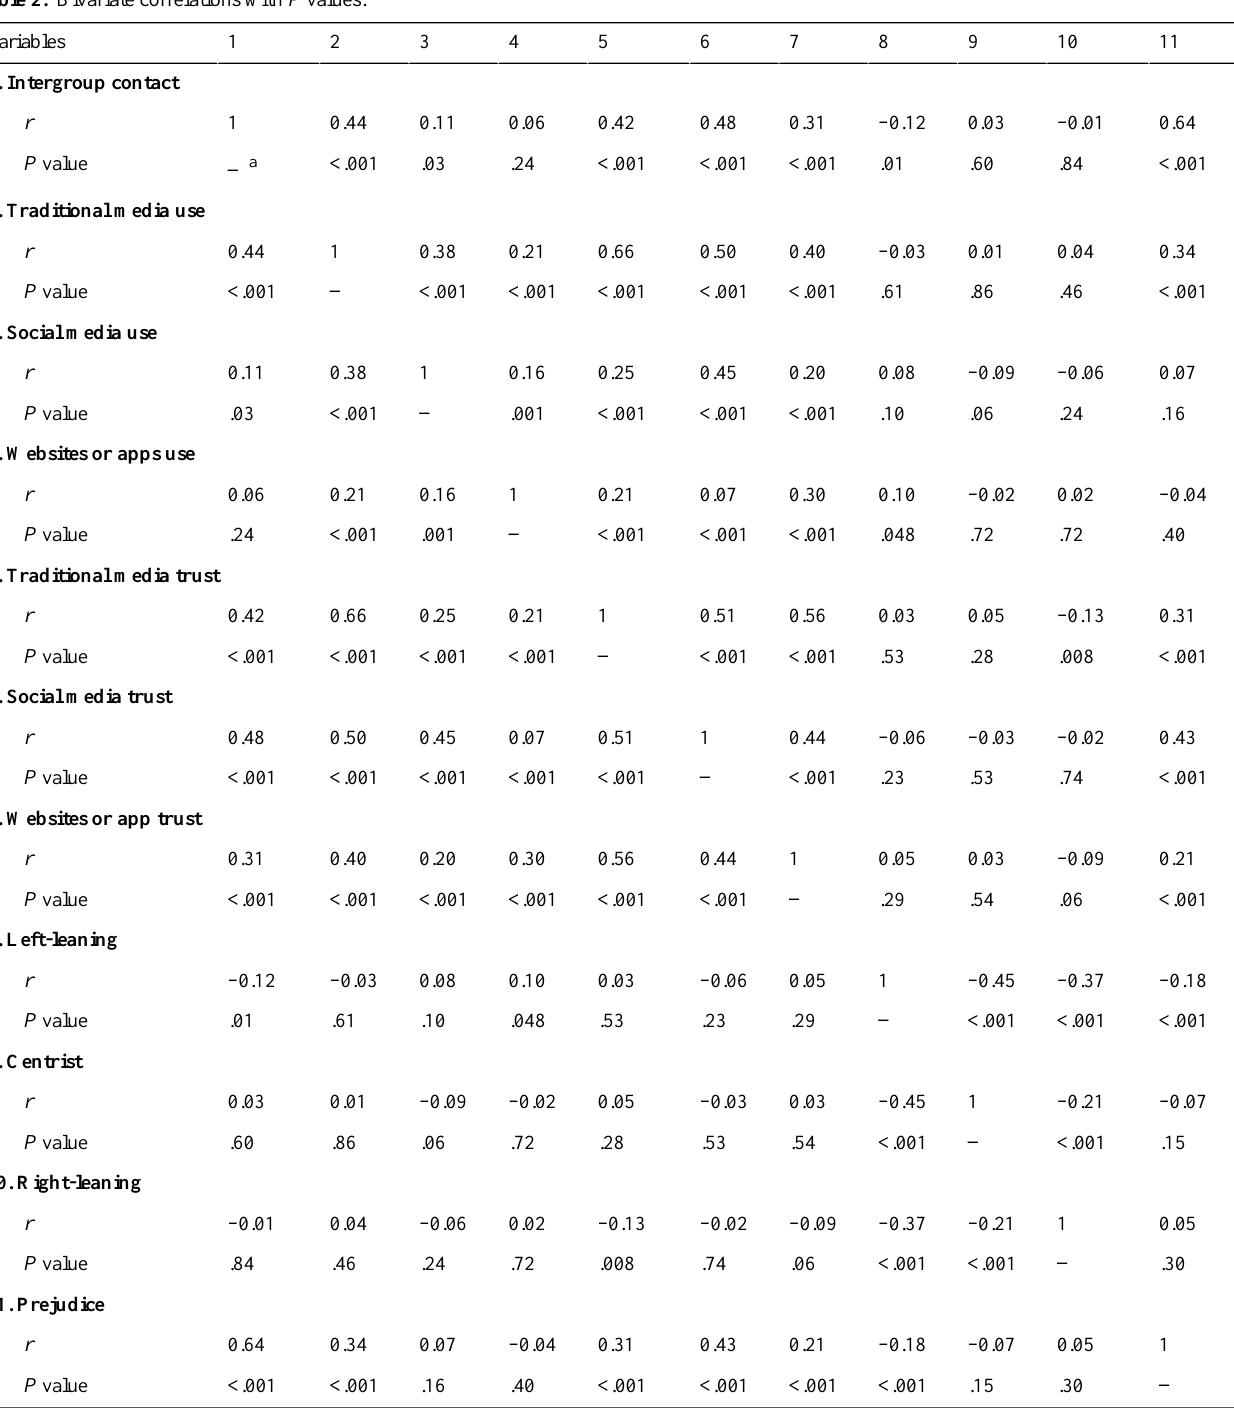
Table 2. Bivariate correlations with P